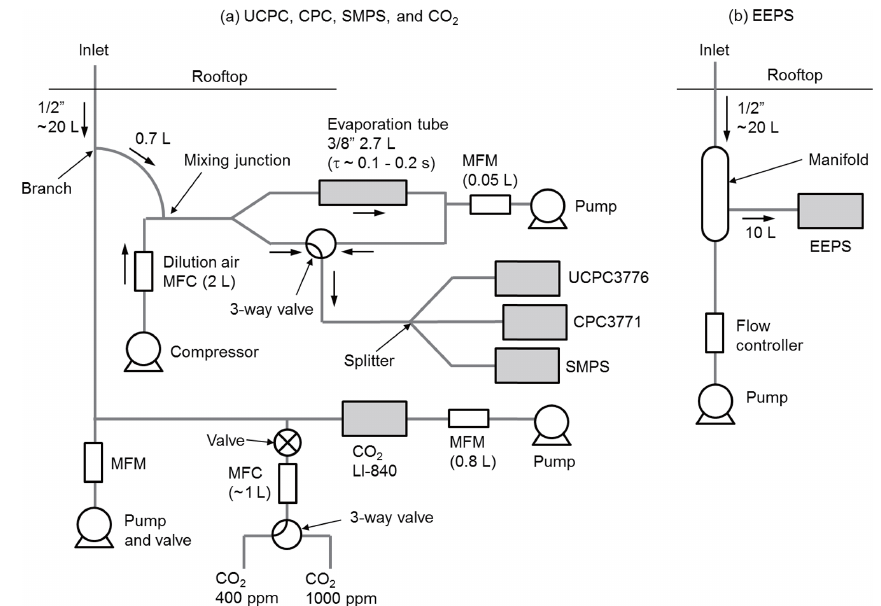
Figure 2. (a) Schematic of the sampling setup for the UCPC, CPC, SMPS, and CO 2 monitor. Ambient air was drawn into one of the two containers through a stainless-steel tube and was split into a bypass flow and sample flows for aerosols and CO 2 . The aerosol sample flow was diluted by particle-free air regulated by a mass flow controller (MFC) to extend the concentration range measured by the UCPC and CPC. The diluted sample flow was then passed through a heated stainless-steel tube (evaporation tube) for heated sampling or a bypass tube for unheated sampling. The flow was switched between the two paths by an automated three-way valve downstream. The tube downstream of the three-way valve was split into individual sample flows for the UCPC, CPC, and SMPS. An additional small flow ( ∼ 0 . 05Lmin − 1 ) was maintained by an orifice, a mass flow meter (MFM), and a pump to avoid the creation of a reverse stream from the evaporation tube during unheated sampling. (b) Schematic of the sampling setup for the EEPS. Ambient air was drawn into the other container through a copper tube, electrically conductive tubes, and a glass manifold. The sample flow for the EEPS was taken from the manifold. The total flow through the copper tube was maintained by a pump downstream of the